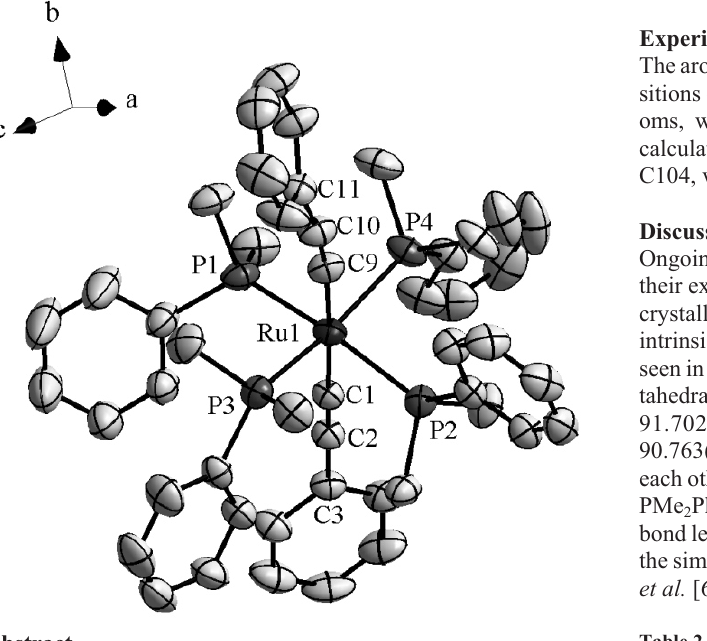
Table 2. Atomic coordinates and displacement parameters (in Å 2 )